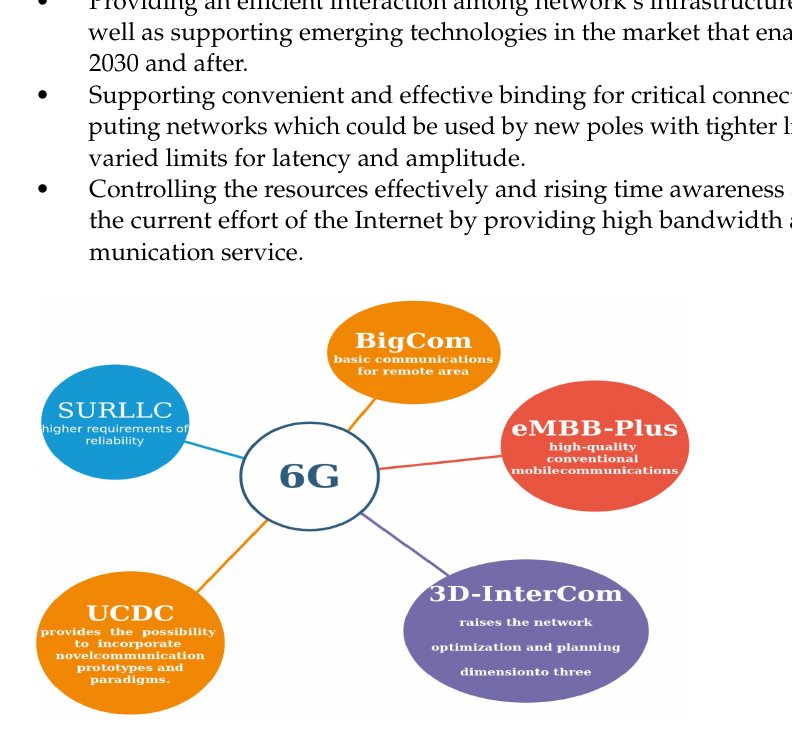
Figure 1. Vision of